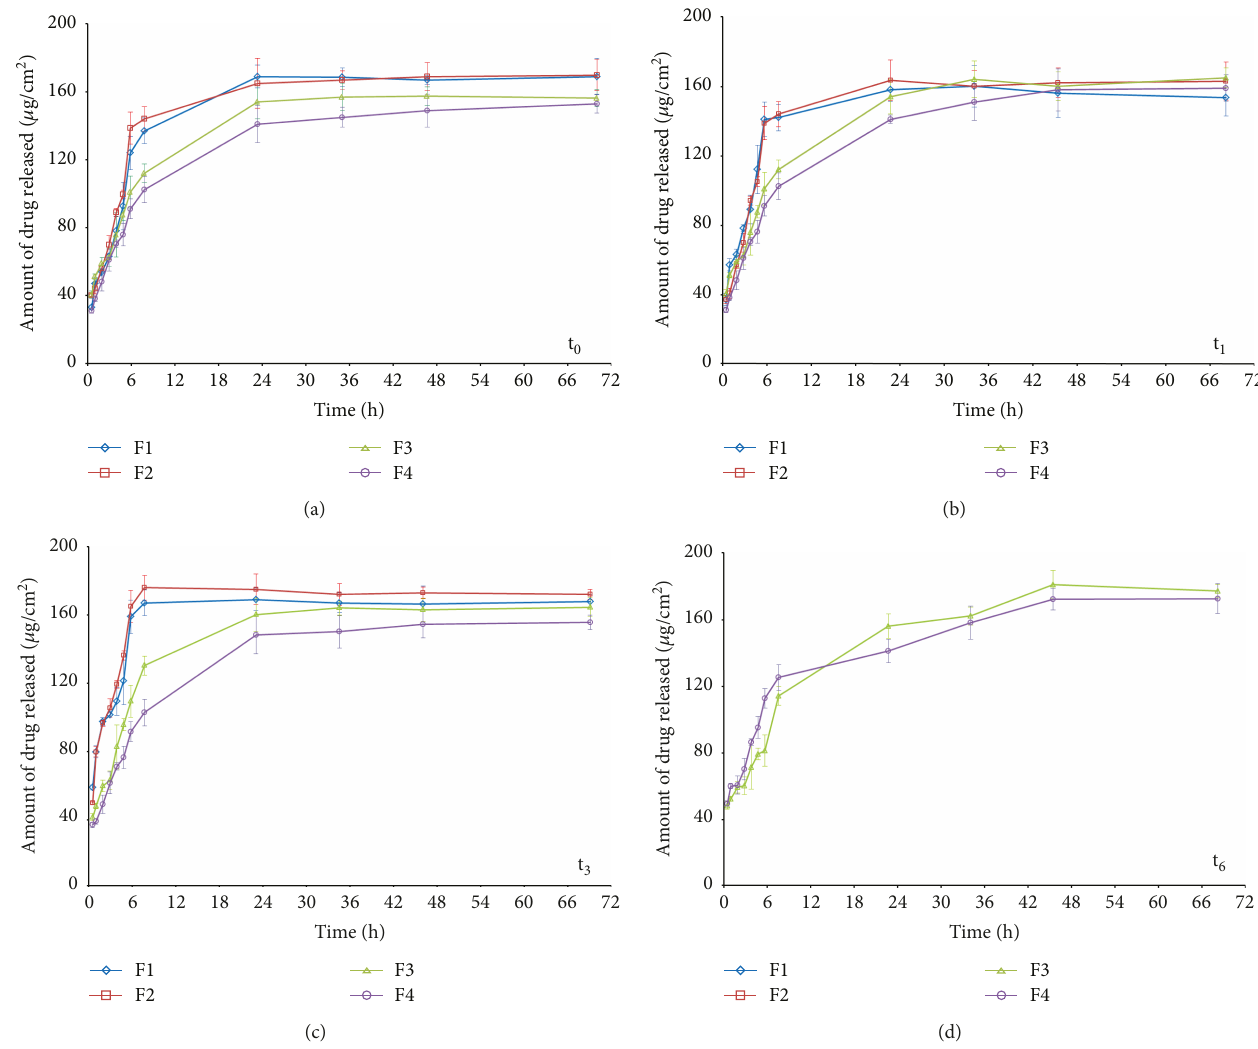
Figure 5: Amount of clotrimazole per unit area ( μ g/cm 2 ) released from hydrogel with unmodi fi ed CS (F1, F2) or with bGP-crosslinked CS (F3, F4): (a) directly after preparation ( t 0 ) and (b) upon 1-month ( t 1 ), (c) 3-month ( t 3 ), or (d) 6-month ( t 6 ) storage at refrigerated conditions ( n = 3 , mean ±